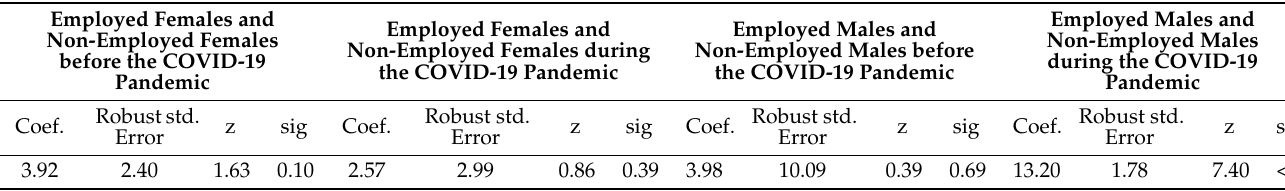
Employed Males and Non-Employed Males before the COVID-19 Pandemic